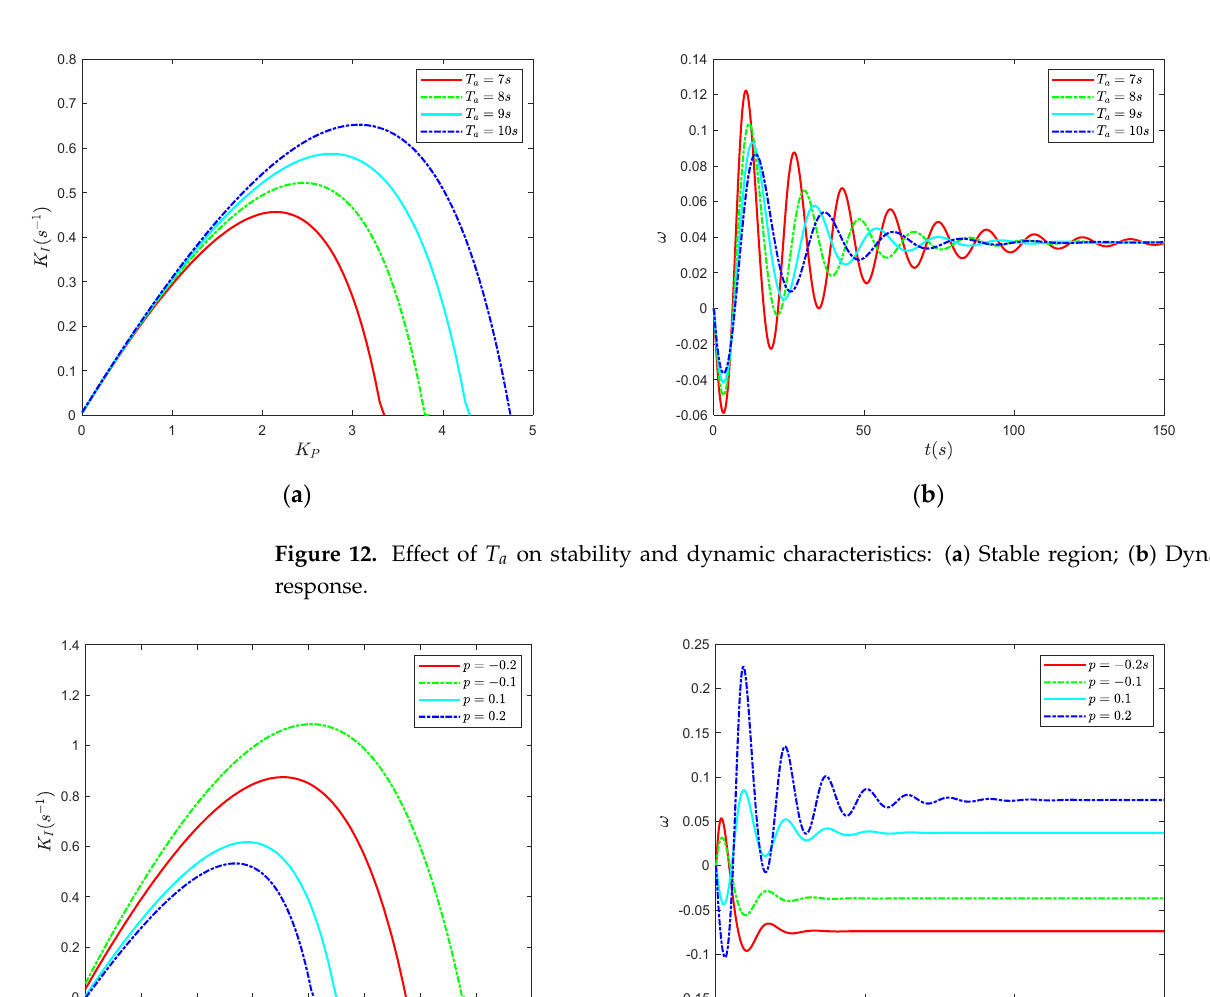
Figure 11. Effect of h H 0 on stability and dynamic characteristics: ( a ) Stable region; ( b ) Dynamic response.